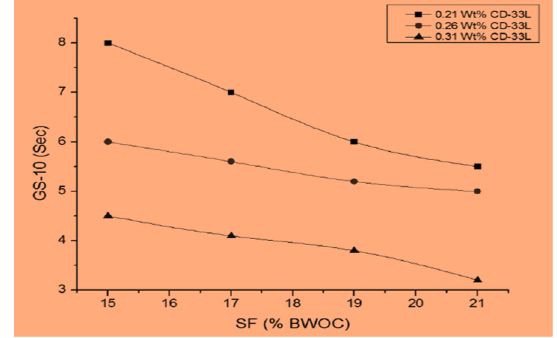
FIG. 4. EFFECTS OF SF AND DISPERSANT ON 10 GS-10 SEC OF 13 PPG SLURRY